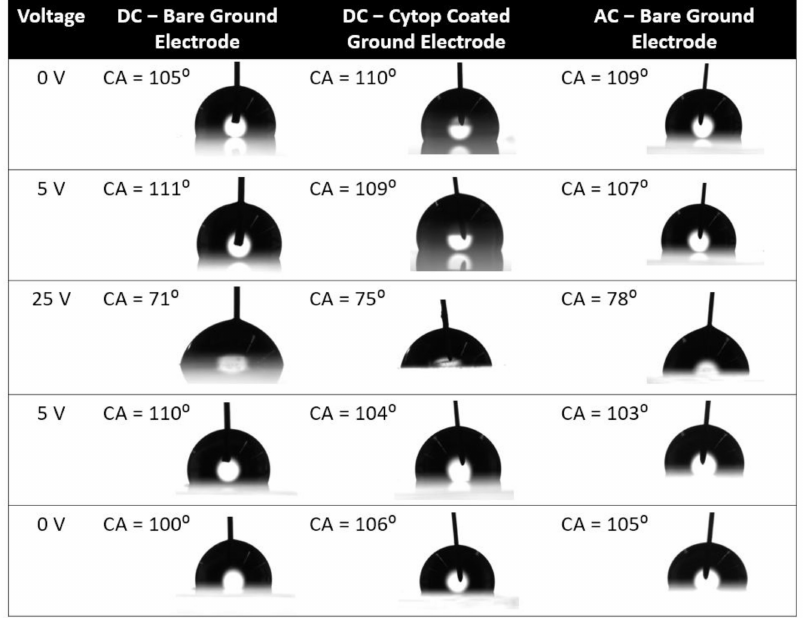
Figure 6. Contact-angle (CA) of the sessile drop in electrowetting with DC-bare ground electrode, DC-Cytop-coated ground electrode and AC-bare ground electrode. Time increases from top to bottom with the voltage increasing and then decreasing.